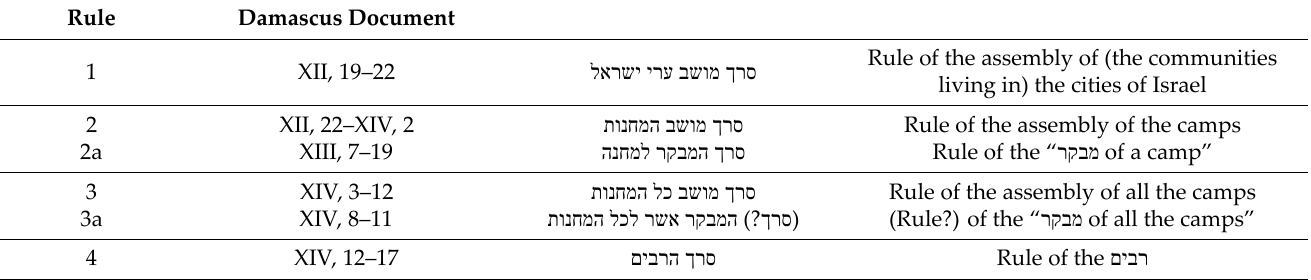
Table 1. Rules in Damascus